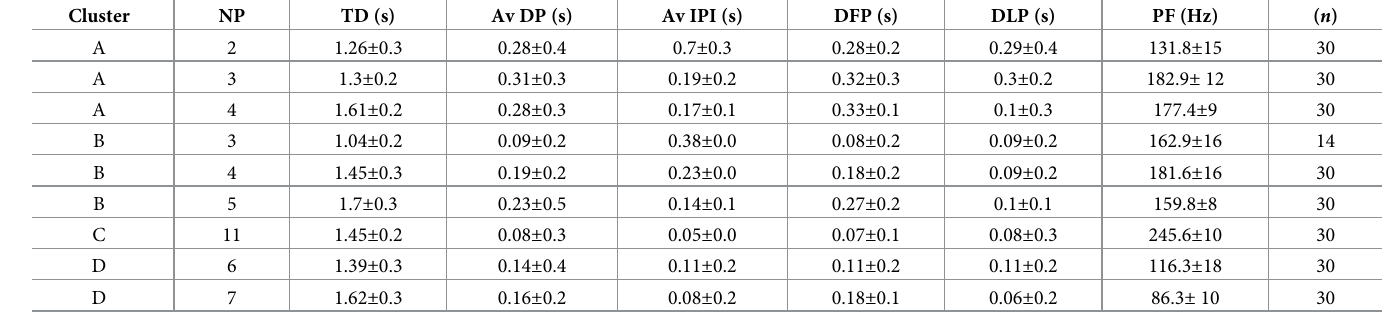
Table 2. Antarctic minke whale Bio-duck call extracted measurements with the amplitude detector. All time variables measured in seconds (s) , (n) = no of samples, Peak Frequency measured in Hertz.